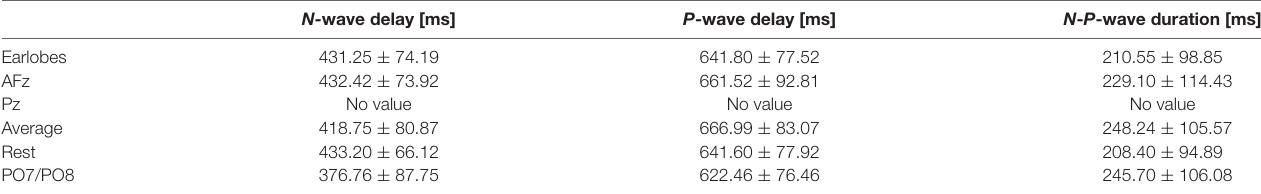
TABLE 2 | N - and P -wave delays and N - P -wave duration for every reference site for the 54 ◦ C stimulation temperature and their respective standard deviations. N- wave delay [ms] P -wave delay [ms] N - P -wave duration [ms]